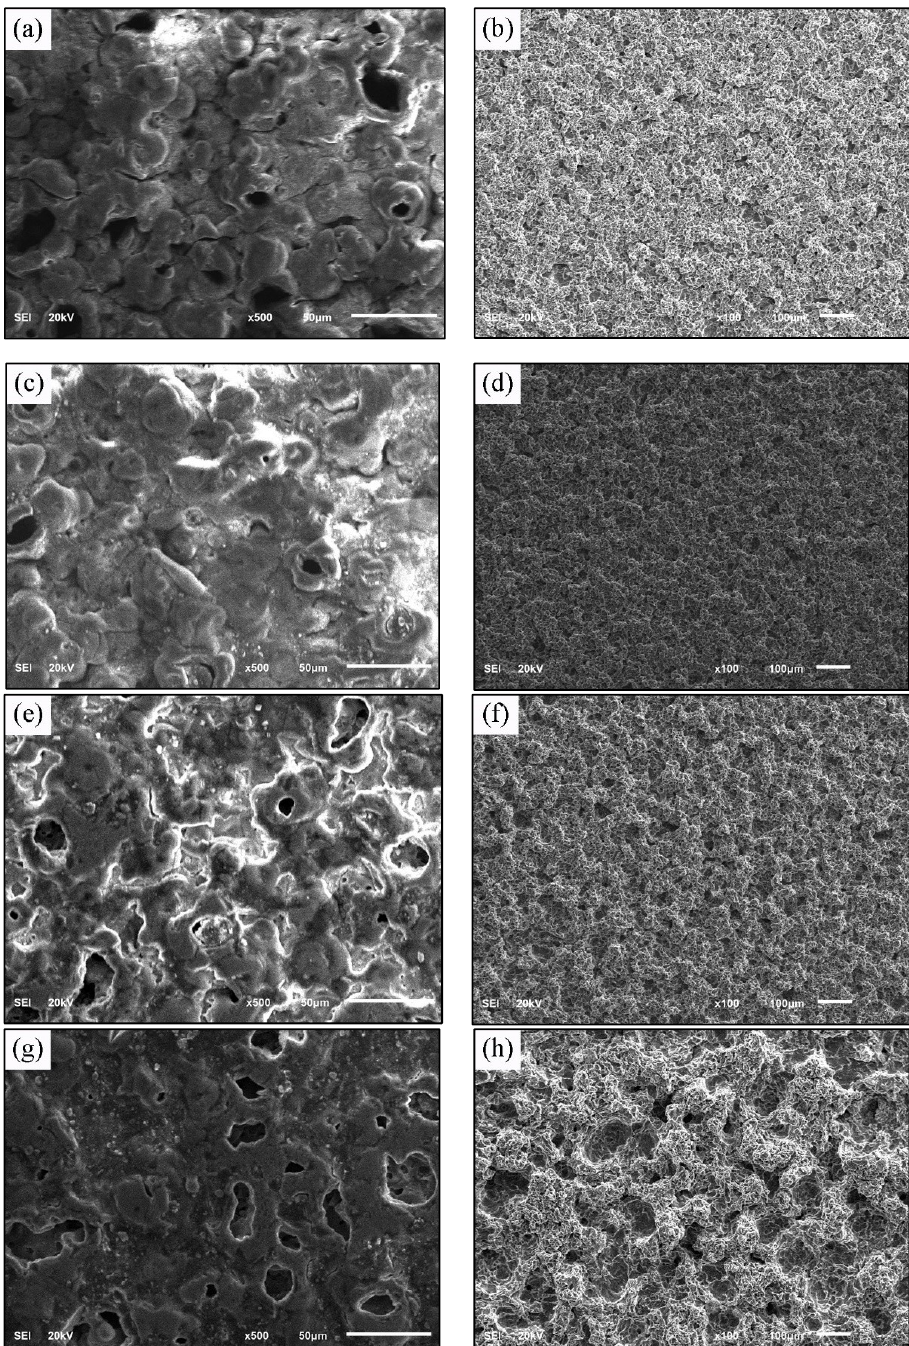
Figure 4. The SEM images of the typical damaged area of the four specimens before and after 10 min test. ( a ) micro-arc oxidation (MAO)-1 before test; ( b ) MAO-1 after test; ( c ) MAO-2 before test; ( d ) MAO-2 after test; ( e ) MAO-3 before test; ( f ) MAO-3 after test; ( g ) MAO-4 before test; ( h ) MAO-4 after test.